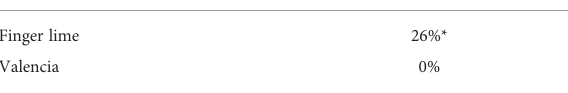
TABLE 6 Percent of images with zero callose plugs per 10x fi eld image of the stem phloem of Ca Las+ ‘ Valencia ’ sweet orange and fi nger